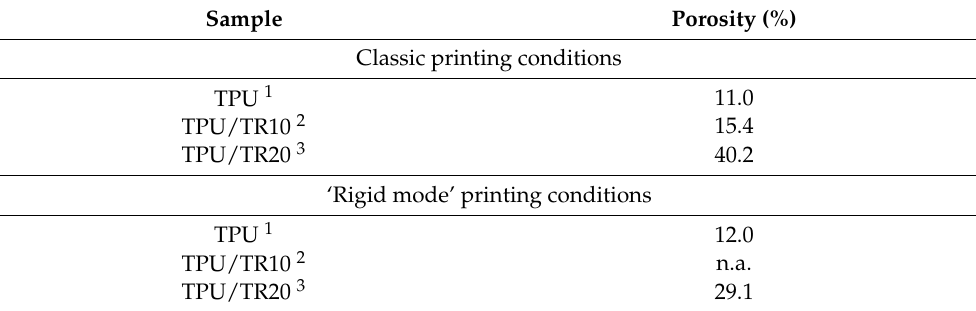
Figure 9. SEM micrographs of TPU/TR20 (TR particles enclosed in orange) ( A ) and TPU ( B ) printed sample. Table 5. TPU-based printed sample